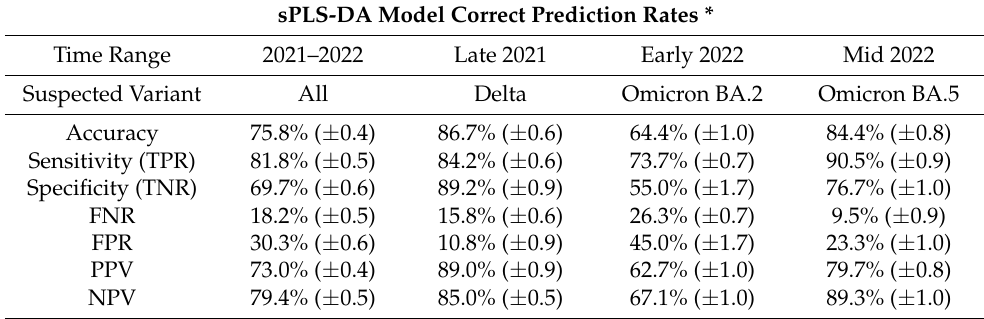
Table 3. Overall and Variant-Specific sPLS-DA